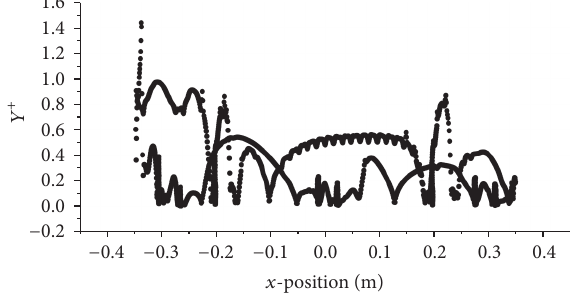
Figure 7: Wall 𝑌 + value of Case #0 ( 𝑈 𝑟 = 2.092